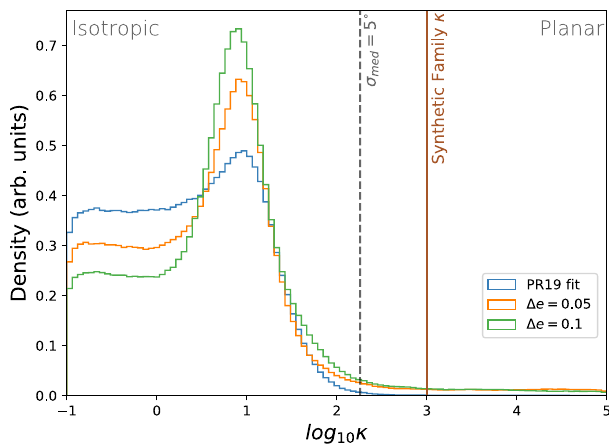
Fig. 3 Comparing our integrations to the true family. A comparison between the posterior probability distribution of κ — the planar concentration parameter — of our two integrations (in orange and green) and the κ distribution from PR19 found for the true family (in blue). Marked with a gray dashed line is the value of κ above which a synthetic family could be explained by a graze-and-merge collision ( σ ≲ 5°). We also mark in brown the value of κ which the planar family was created with. Only ~3.5% of the posterior distribution of our integrations is consistent with a graze-and-merge formation, similar to the 1% found for the actually observed Haumea family. All three posteriors display a large peak near κ = 10, which is attributable to over fi tting. This demonstrates that Neptune migration can mix a graze-and-merge family into an a-e-i distribution similar to the observations, though we emphasize that it is not equivalent to fi tting the proposed model to the observational data. Source data for this fi gure are provided as a Source data fi